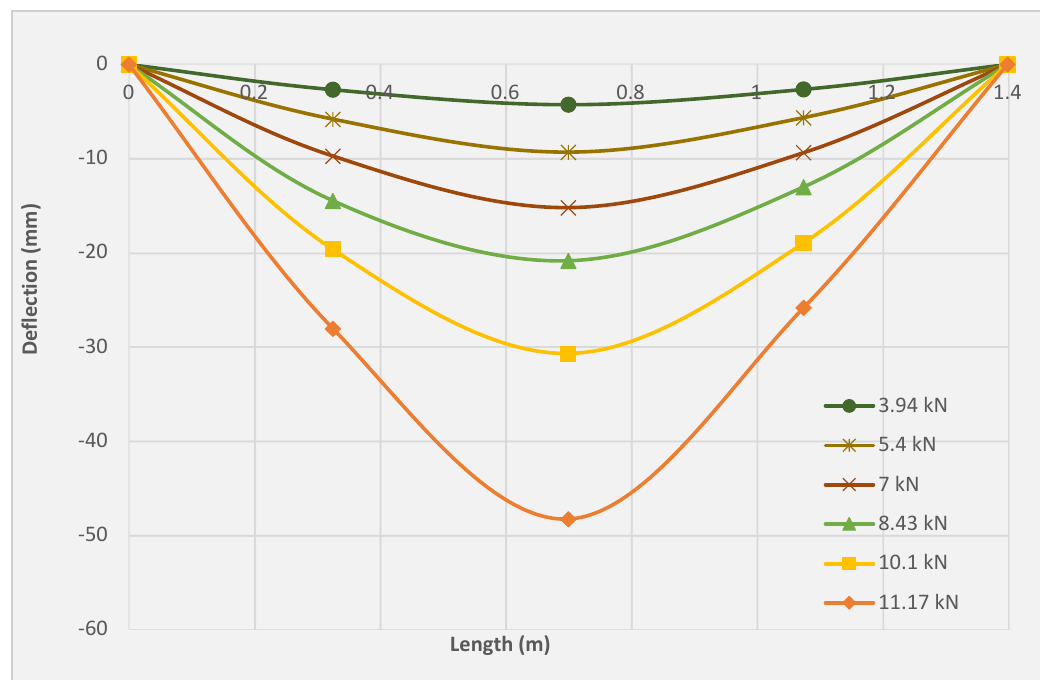
Figure 13. Deflection profile for the SRC + 2T tested slab.